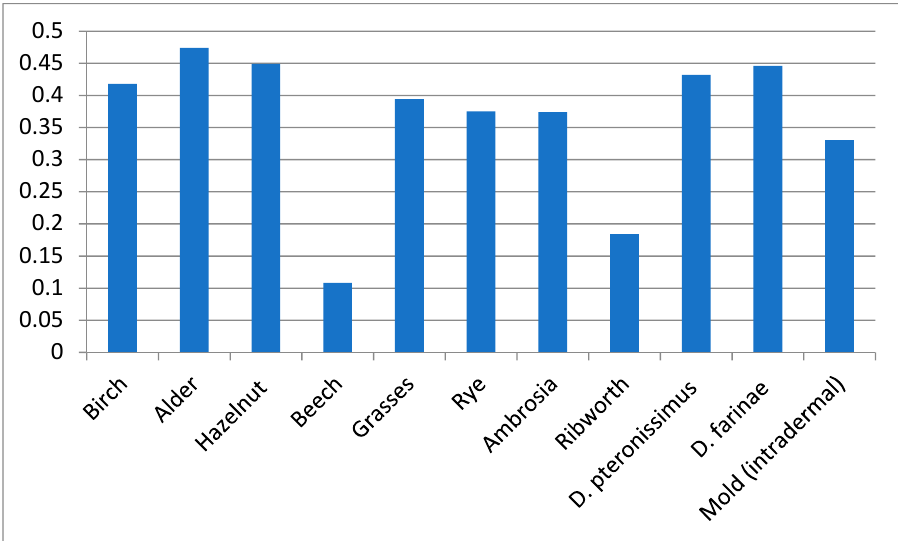
Figure 3. Kappa coefficients when comparing SPT and specific serum IgE.